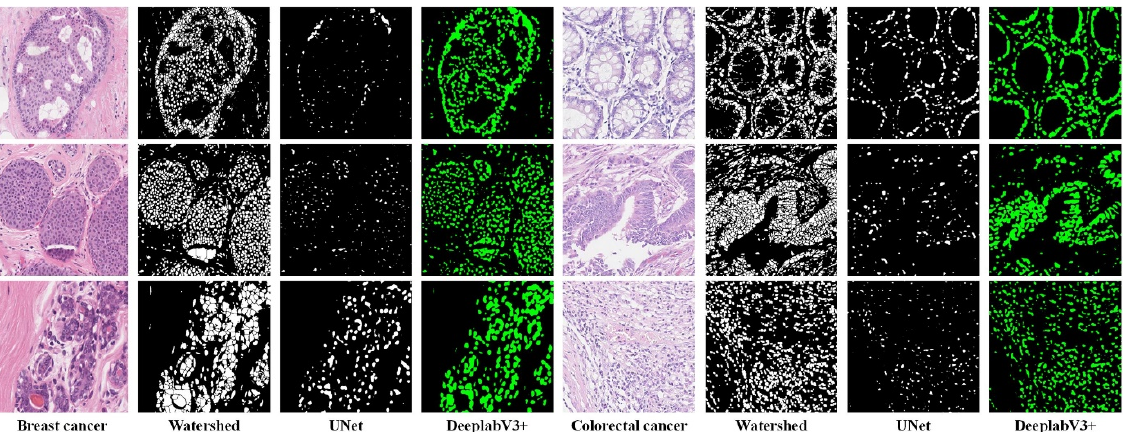
Figure 7. Nuclei segmentation results using different methods on two datasets. The Watershed method leads to merged nuclei (over-segmentation) and the UNet method leads to fragmented nuclei (under-segmentation).